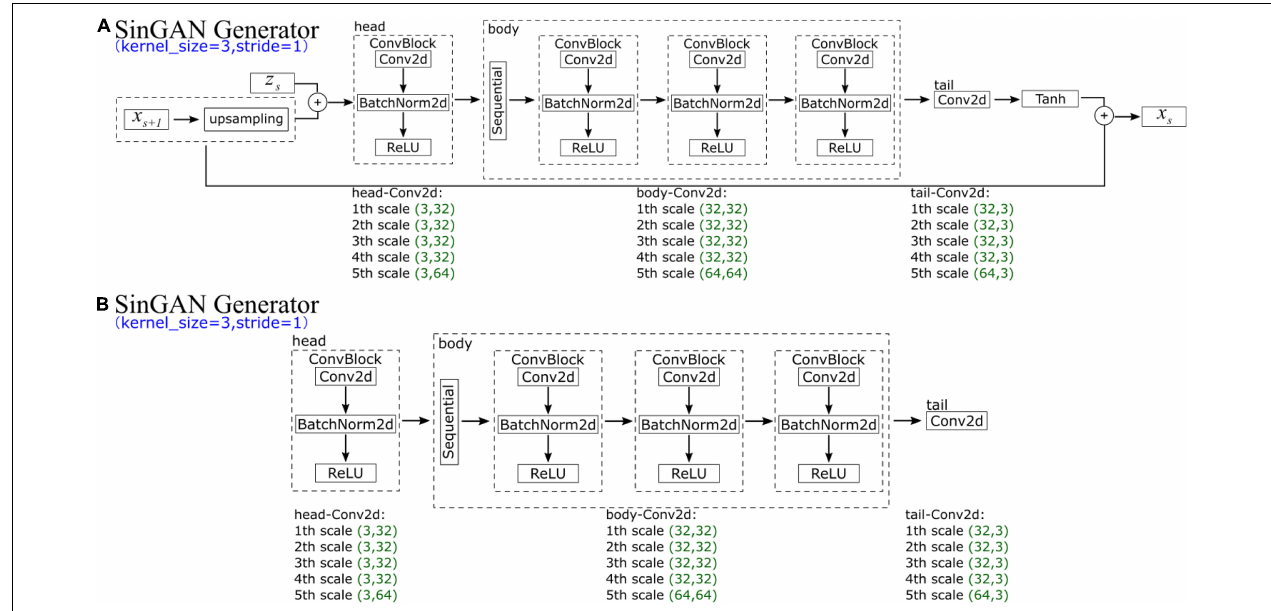
FIGURE 6 | Schematic diagram showing the (A) generator and (B) discriminator of